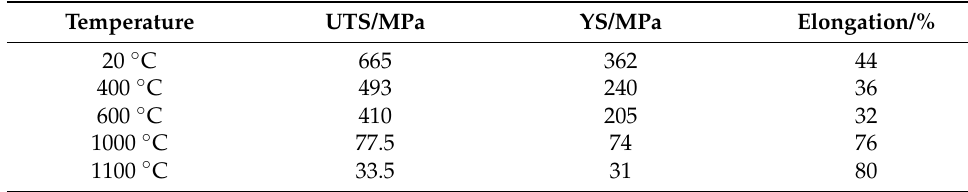
Table 3. Mechanical properties of the welded joints at elevated